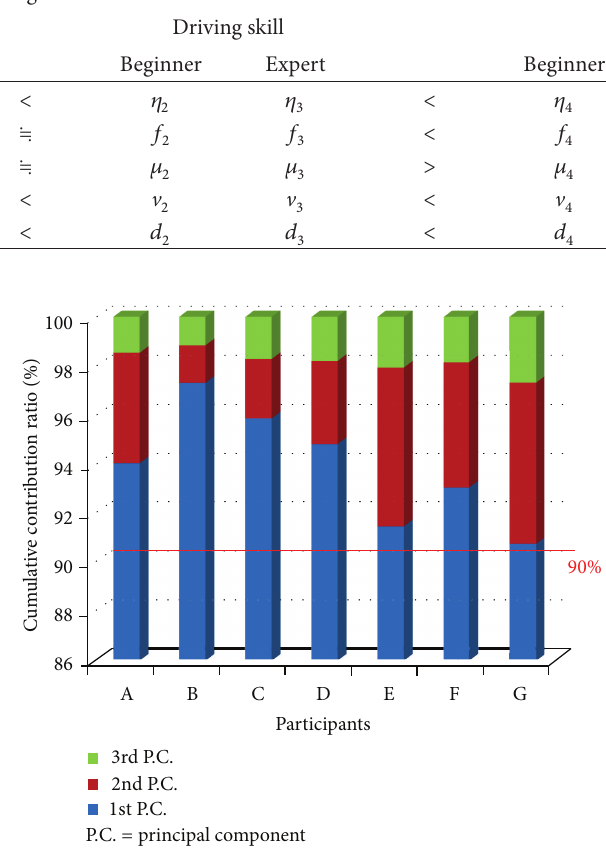
Figure 9: Cumulative contribution ratio of each principal compo-